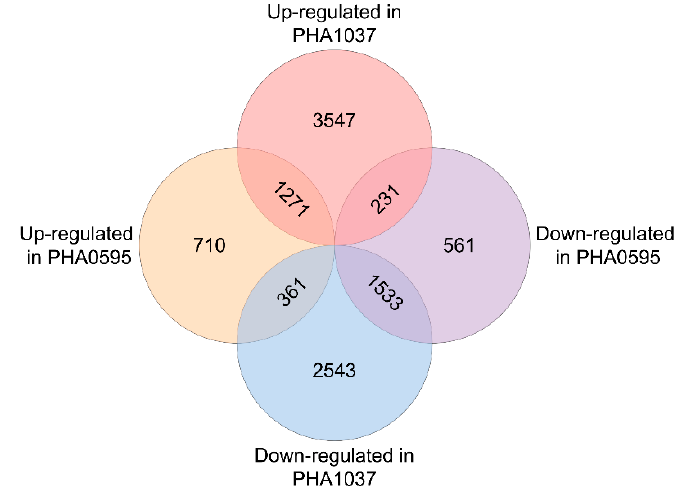
Figure 2. Venn diagram for differentially expressed gene sets in PHA1037 and PHA0595. Details of the differentially expressed genes can be found in Tables S2–S8.